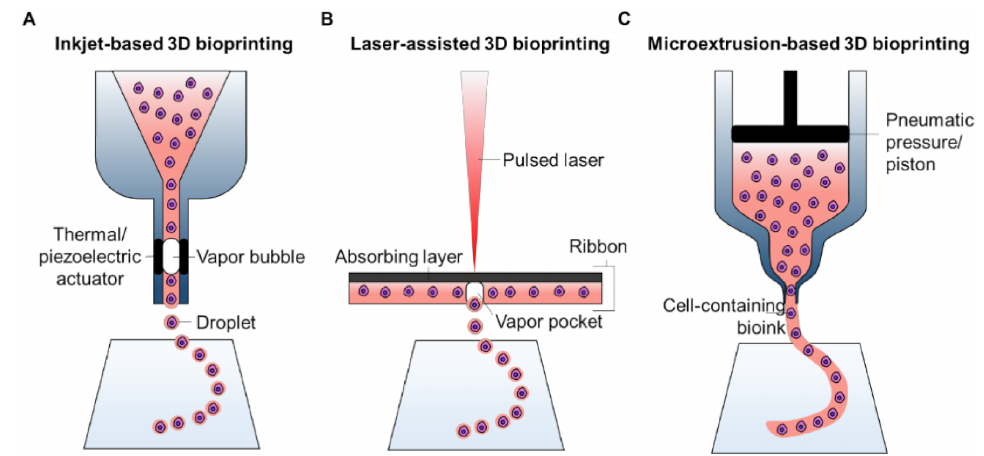
Figure 2. Schematic illustration of 3D bioprinting systems, including ( A ) inkjet-based, ( B ) laser- assisted, and ( C ) microextrusion-based 3D bioprinting